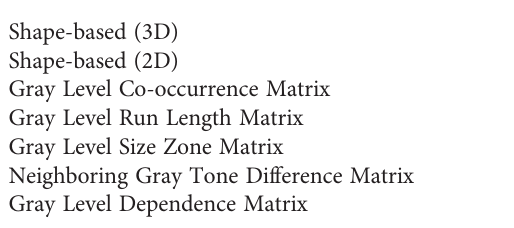
FIGURE 2 | Methodology used to evaluate the predictiveness of location-based features independently and in combination with radiomics for overall